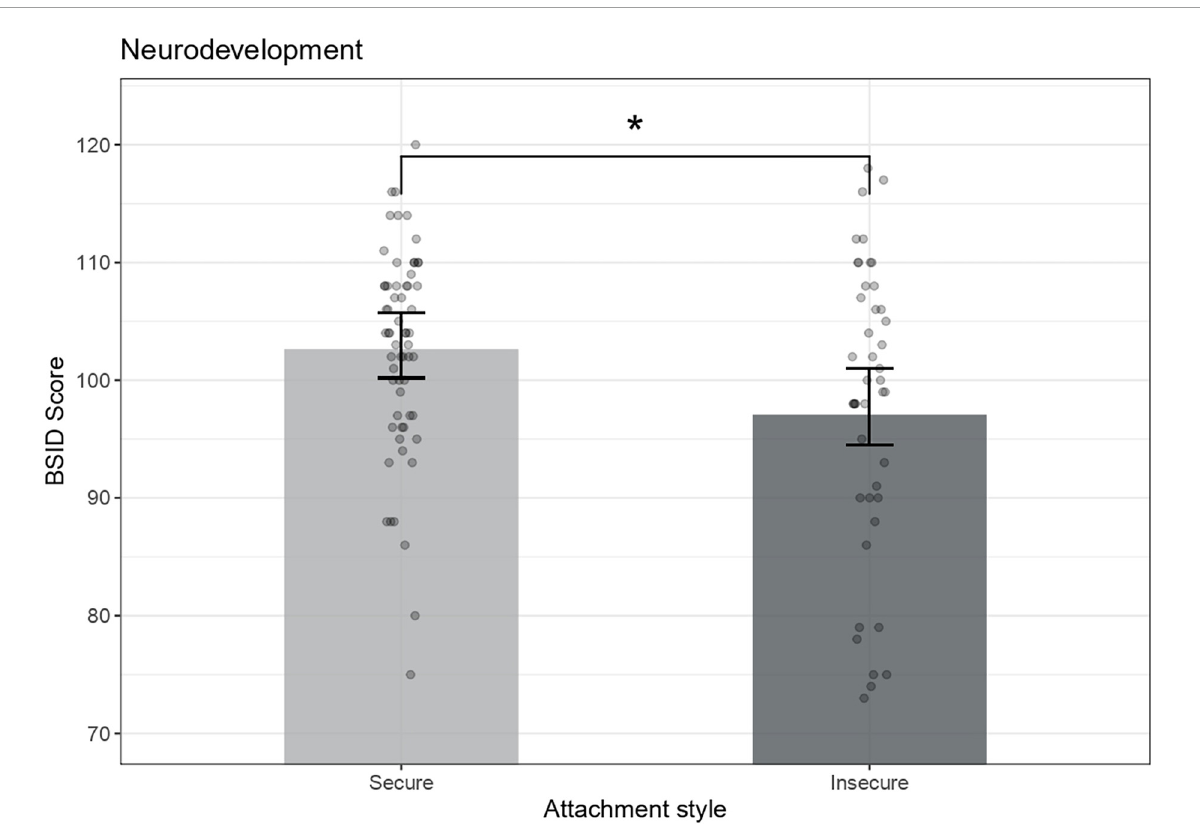
FIGURE2 Preschoolers’ neurodevelopment across attachment groups. Bayle Scales of Infant Development mental scores are adjusted for child’s sex [ F (1,96) = 7.76, p = 0.023]. Error bars represent 95% confidence intervals of the means, * p < 0.05.